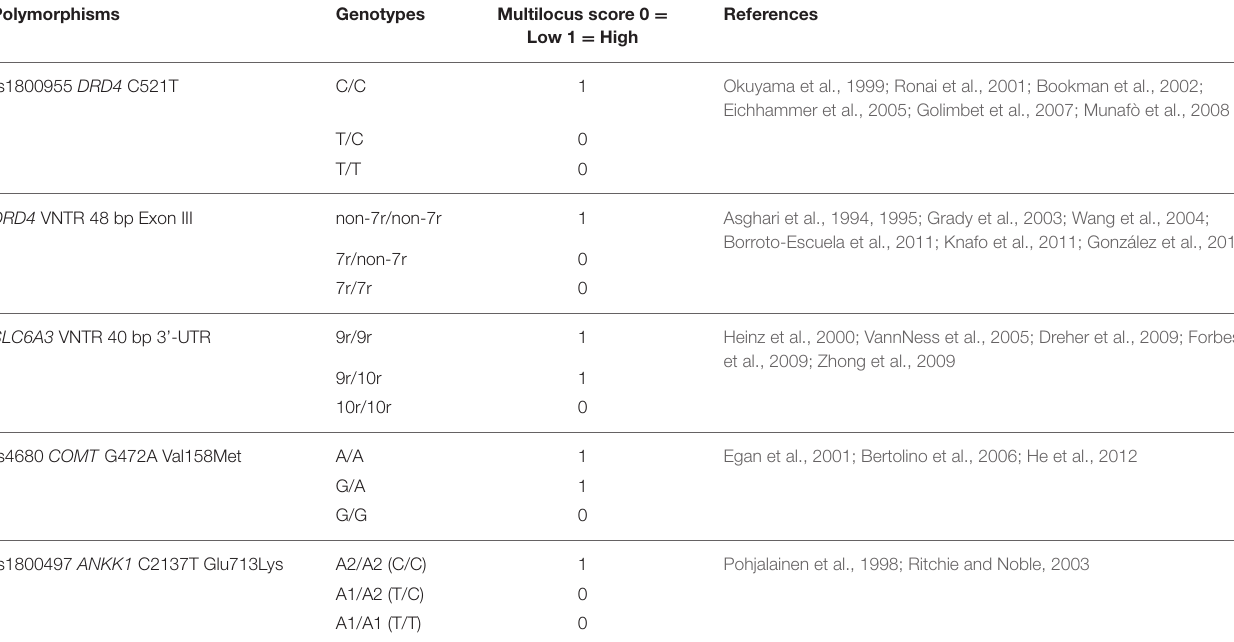
TABLE 3 | Scores assigned to each variant genotype (1 = high activity; 0 = low activity), according to the indicated references, to create the multilocus genetic